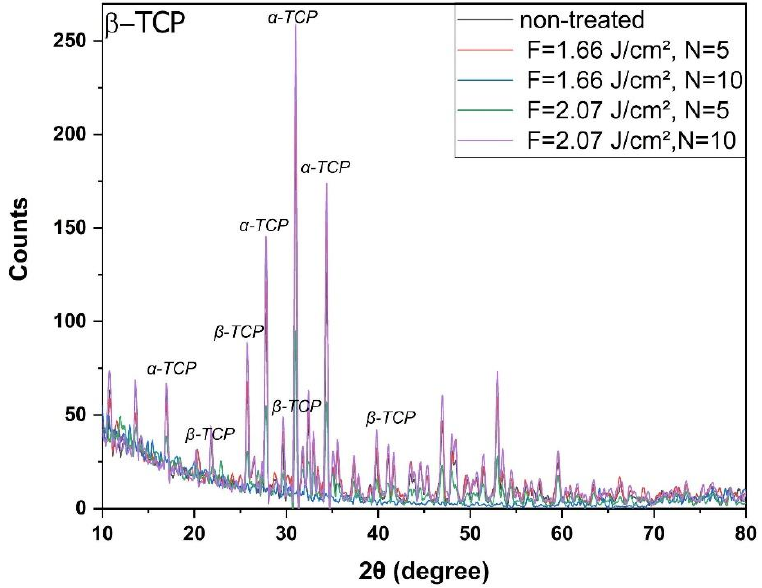
Figure 8. X-ray diffraction patterns of control/ β -TCP surfaces treated by laser irradiation at F = 1.66 and 2.07 J/cm 2 , N = 5 and 10.